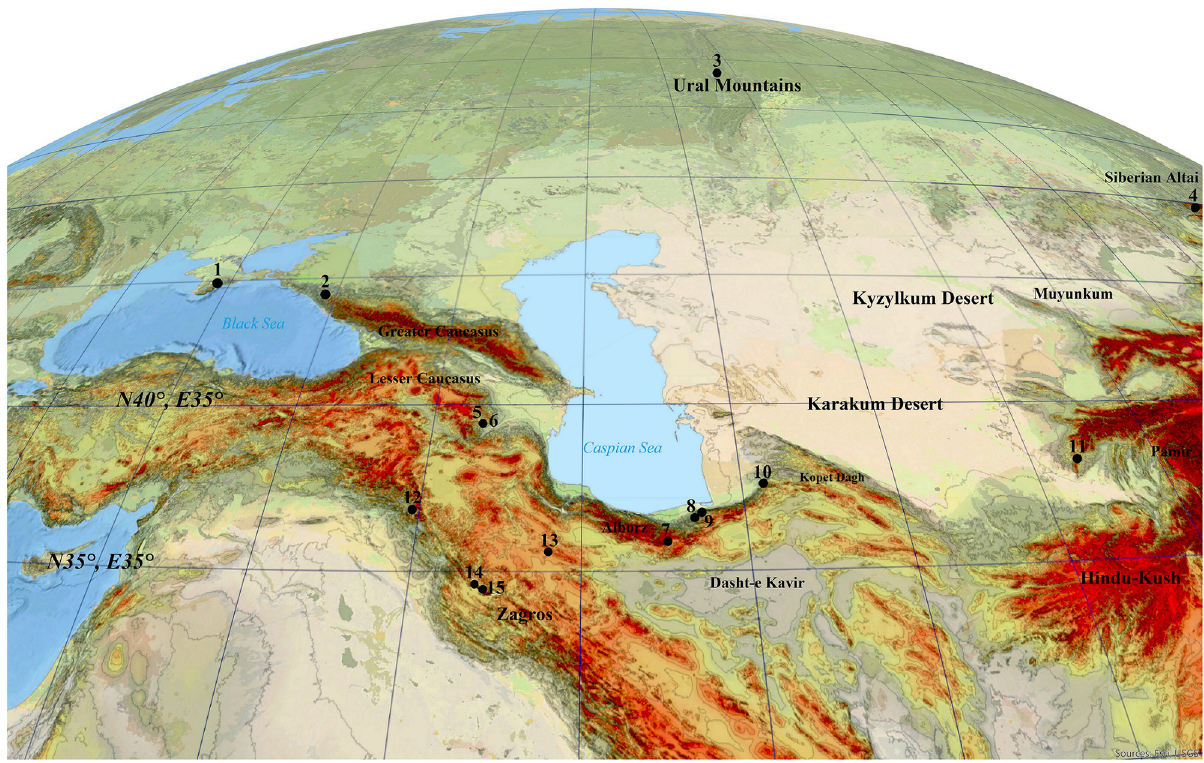
Fig 1. The study area and important Middle Palaeolithic sites mentioned in the text: 1. Crimean sites, 2. Mezmaiskaya, 3. Trans Ural sites, 4. Siberian Altai sites (Chagyrskaya, Denisova, Okladnikov), 5. Azokh, 6. Taglar, 7. Liben, 8. Shoupari, 9. Wezwar, 10. Keyaram, 11. Teshik-Tash, 12. Shanidar, 13. Qale Kord, 14. Bawa Yawan, 15. Bisetun.